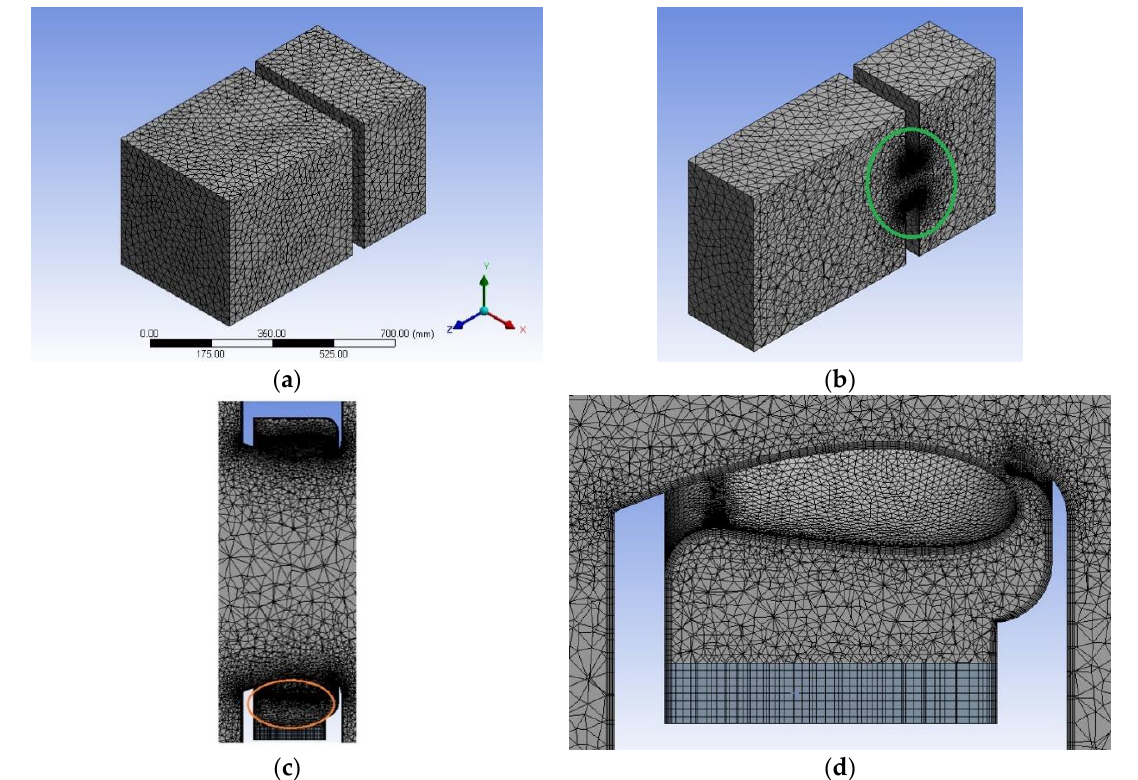
Figure 7. Meshing results. ( a ) The overall appearance of the geometric model, ( b ) the sectional view of the model along its center, ( c ) the inner flow region of the window-type convection device, and ( d ) the flow region on the airfoil surface and outlet slit.